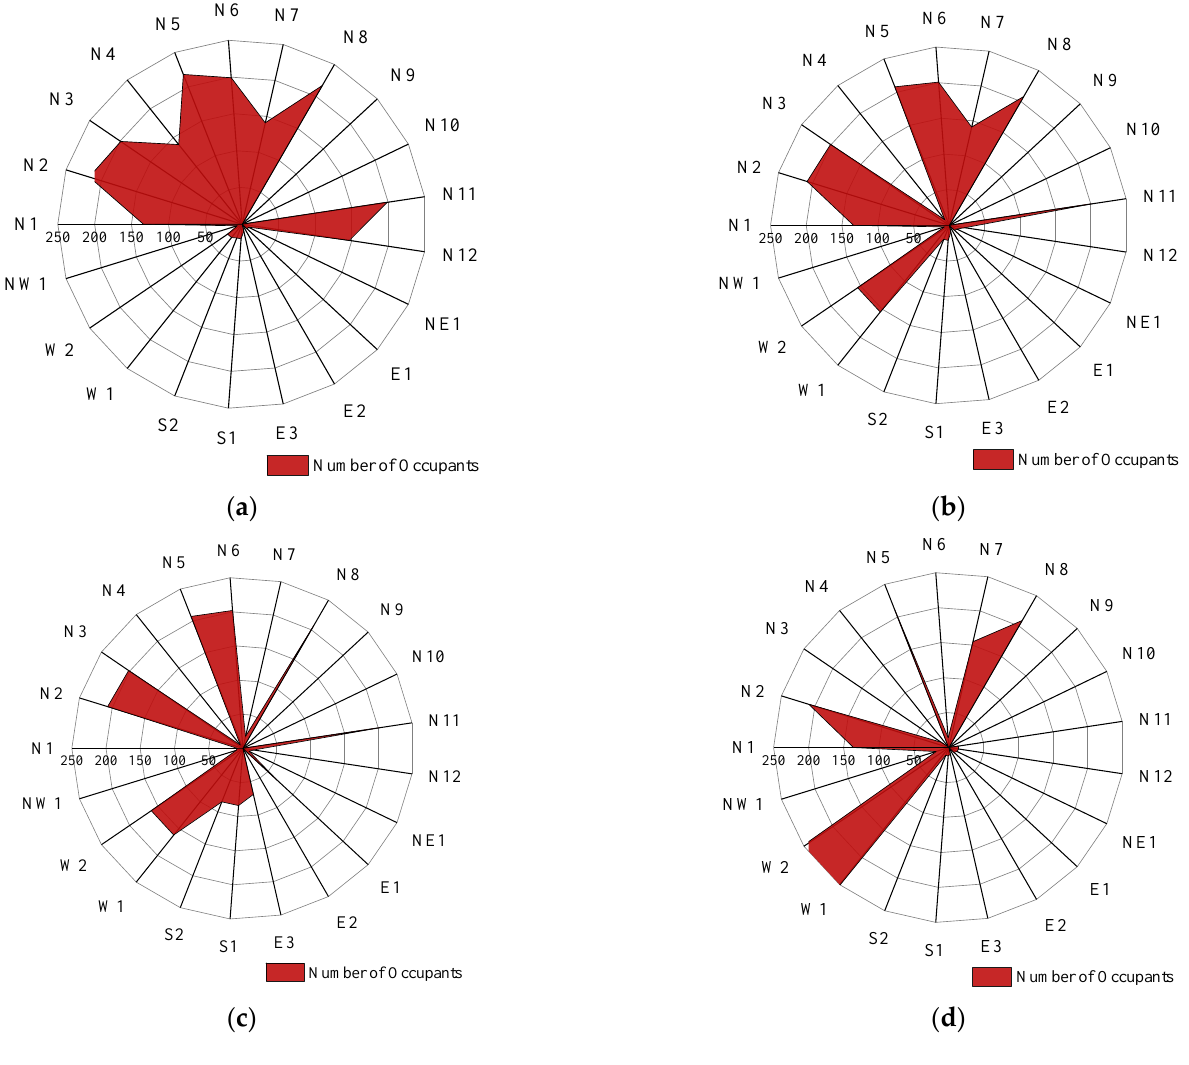
Figure 18. Distribution of the number of people passing through each exit on the first floor of Cases 1A~1D. ( a ) Number of occupants in Case 1A; ( b ) number of occupants in Case 1B; ( c ) number of occupants in Case 1C; ( d ) number of occupants in Case